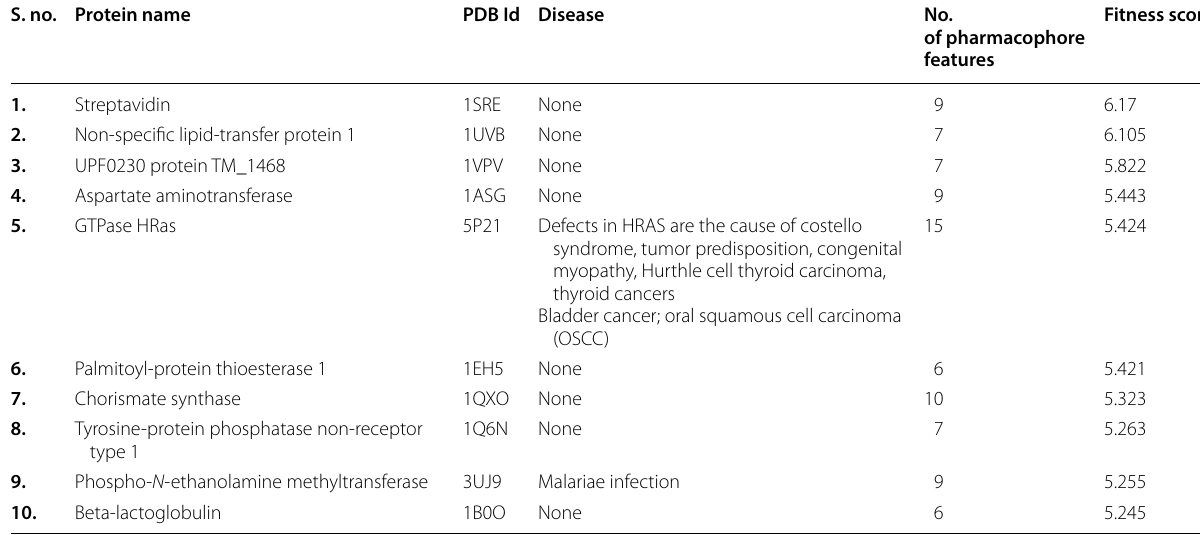
Table 2 Details of top ten protein hits from PharmMapper pharmacophore mapping S. no. Protein name